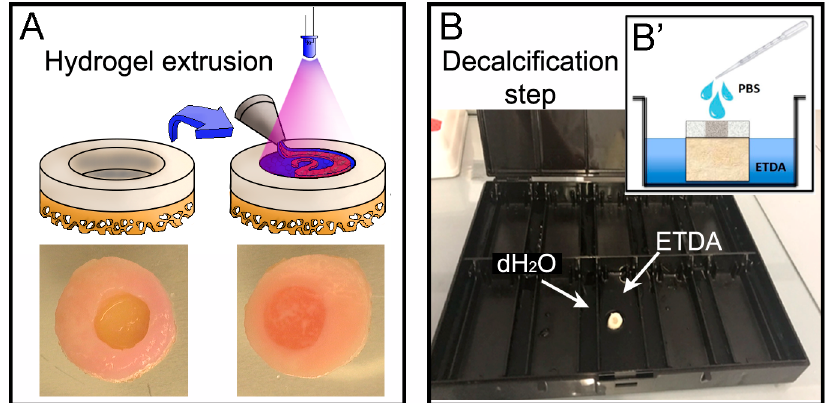
Figure 3. ( A ) Schematic representation of the casting procedure performed to simulate a hydrogel-based reparative approach into the cartilage defect created in the OC plugs. A gelatin-methacryloyl/hyaluronic acid methacryloyl (GelMa/HAMa) hydrogel was used as an example and extruded in to the cartilage defect and UV crosslinked to induce hardening of the material. ( B ) The picture shows the humidified chamber used to decalcify the OC plugs by submerging only the bone region with ETDA solution for a total time of 48 h. To prevent the dehydration of cartilage and hydrogels we added a drop of PBS onto the surface three times a day ( B’